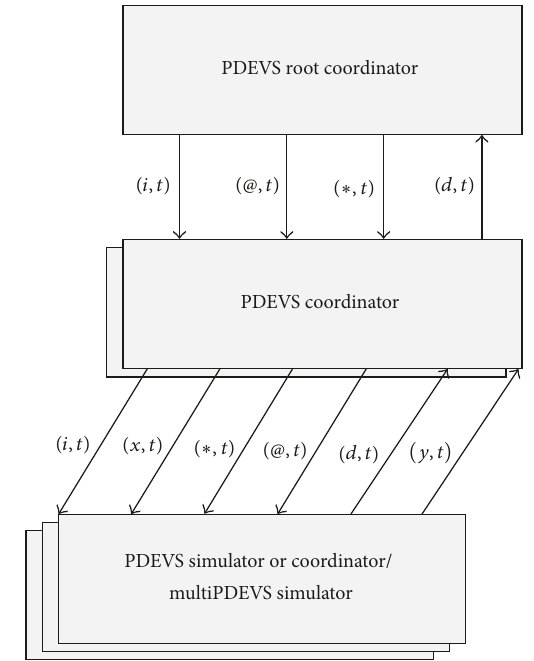
Figure 4: multiPDEVS abstract simulator integrated within PDEVS simulation